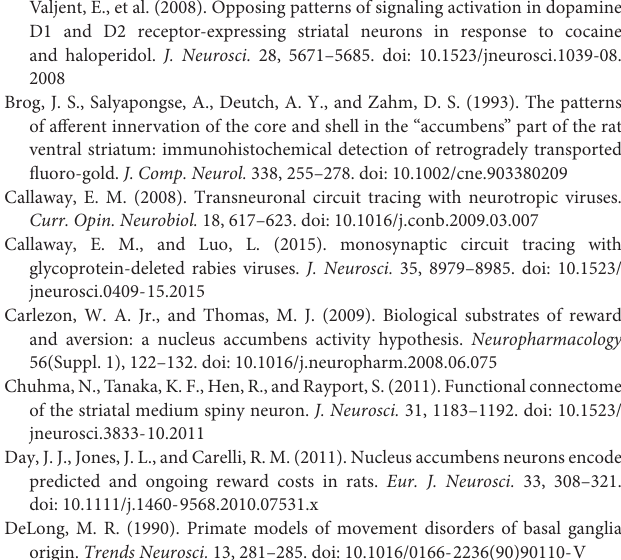
TABLE S1 | Raw data used for